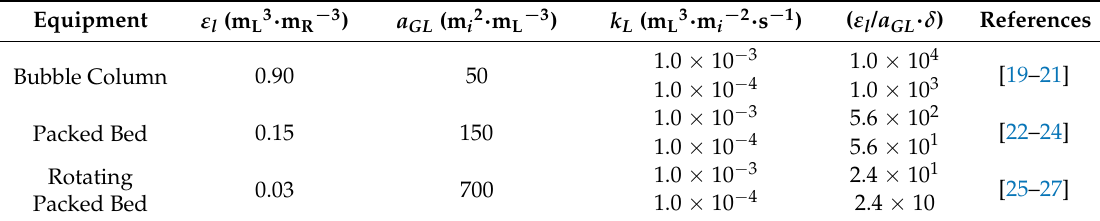
Table 1. Parameters used in the simulations.